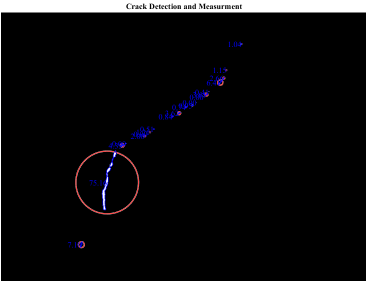
Figure 7. Crack Detection and Measurement